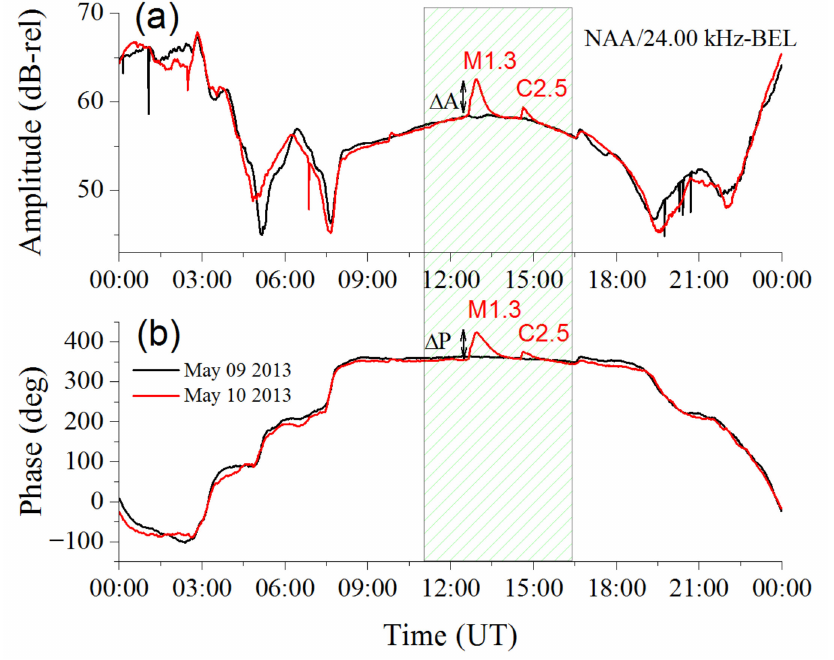
Figure 2. Measured variation of amplitude ( a ) and phase ( b ) on NAA signals for 9 May 2013 (quiet day) and 10 May 2013 with noticeable SF events. Table 1. The data on SFs, amplitude and phase perturbations of VLF signals caused by different events analysed in this study. SF Tim SID VLF Signatures SF Data